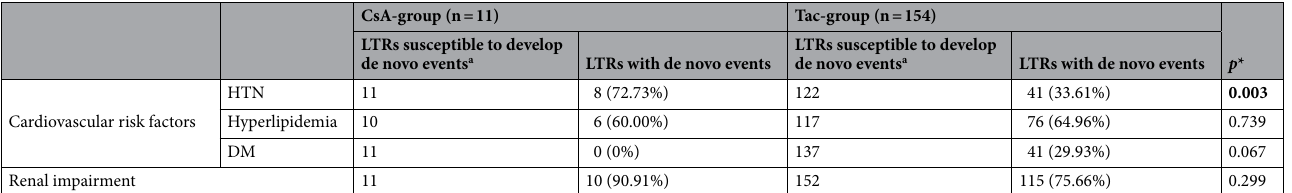
Table 2. Development of de novo cardiovascular risk factors and renal impairment in the post-LTx period. HTN arterial hypertension, CsA‑group patients undergoing immunosuppressive treatment with cyclosporine as maintenance therapy, DM diabetes mellitus, LTRs lung transplant recipients, Tac‑group patients undergoing immunosuppressive treatment with tacrolimus as maintenance therapy. *The boldface type indicates differences that are statistically significant ( p < 0.05). a This column includes LTRs that, at the time of receiving their lung allograft, did not present each of the characteristics that were assessed in the study and were therefore the recipients that were susceptible to develop them.